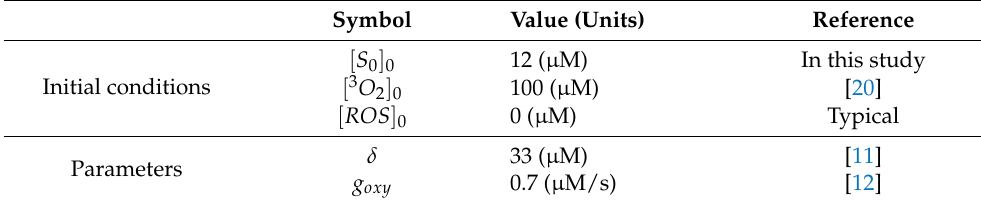
Table 3. Initial concentration of [ S 0 ] , [ 3 O 2 ] , [ ROS ] , and fixed